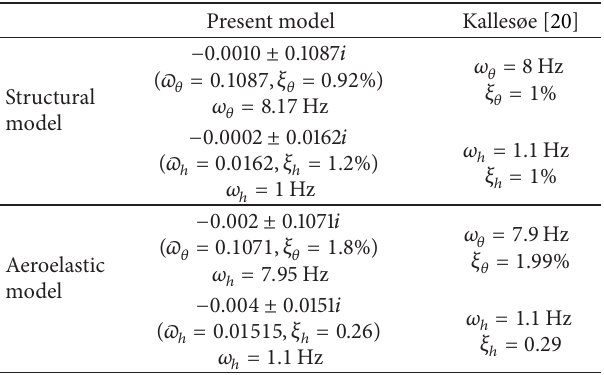
Table 1: Eigenvalues for structural and aeroelastic models with 𝑈 = 11 m/s and 𝛼 = 2 ∘ .